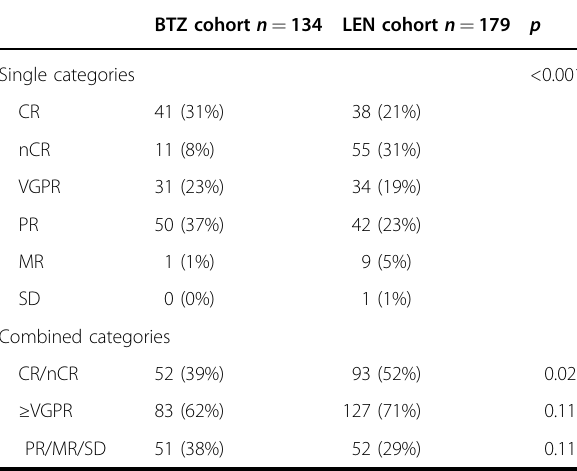
Table 2 Response rates prior to start of maintenance therapy.